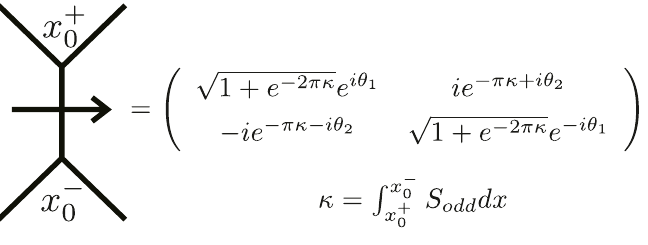
Figure 9 . An MTP structure and its integration